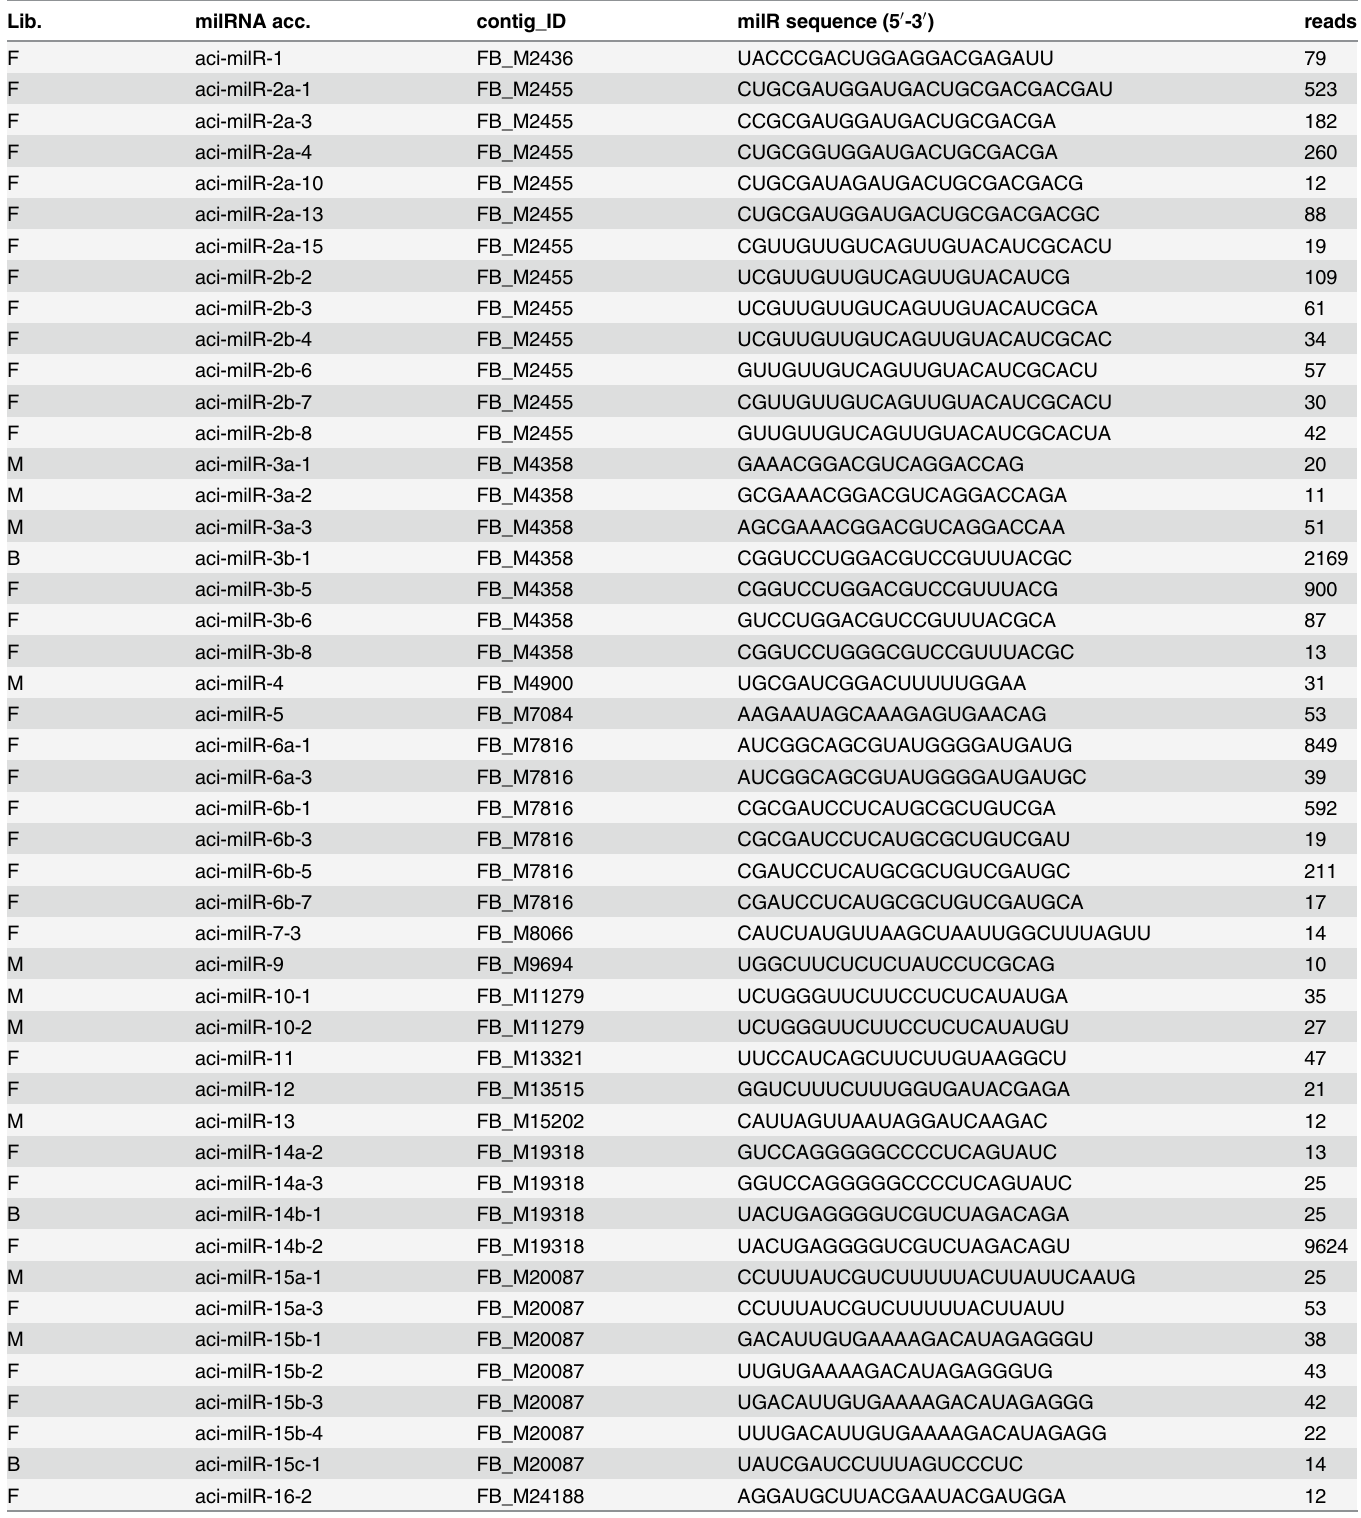
Table 4. Predicted novel milRNA candidates in A . cinnamomea .